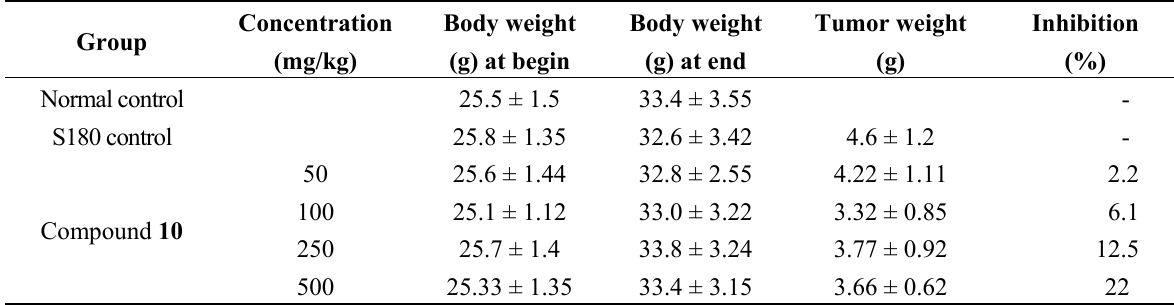
Table 1. Effects of compound 10 on body and tumor weights of S180-bearing mice.